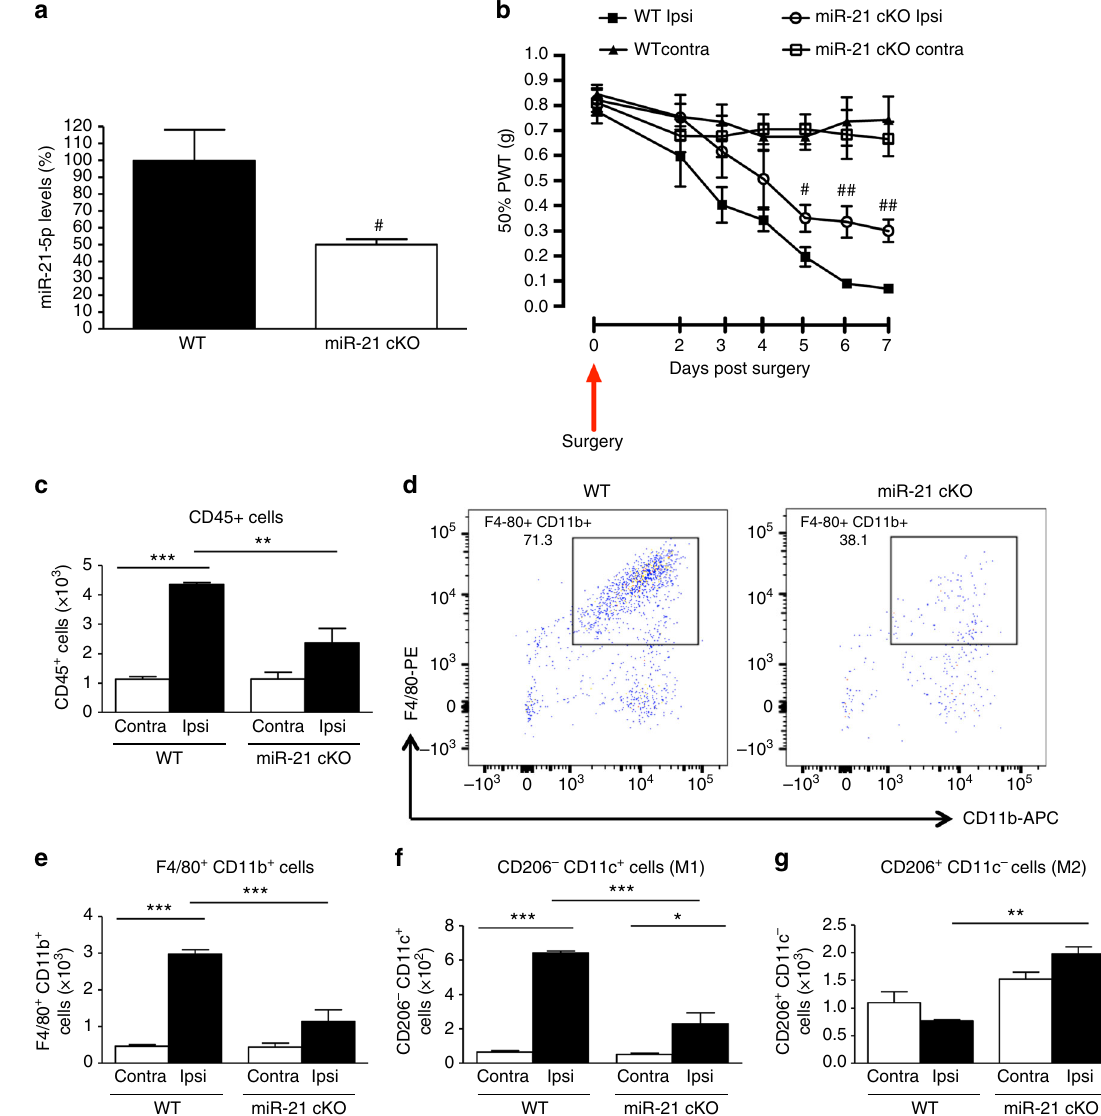
Fig. 10 Conditional deletion of miR-21 in sensory neurons prevents the development of mechanical hypersensitivity and is associated with polarization of macrophages toward an anti-in fl ammatory phenotype. a Downregulation of miR-21-5p levels in DRG of miR-21 cKO compared to WT littermate mice. Data are expressed as means ± S.E.M., n = 5 mice for each group. # P < 0.05 compared to WT, Student ’ s t- test. b Effect of miR-21 deletion in DRG sensory neurons on the development of mechanical hypersensitivity following SNI. Data are presented as 50% of paw withdrawal thresholds (PWT); means ±